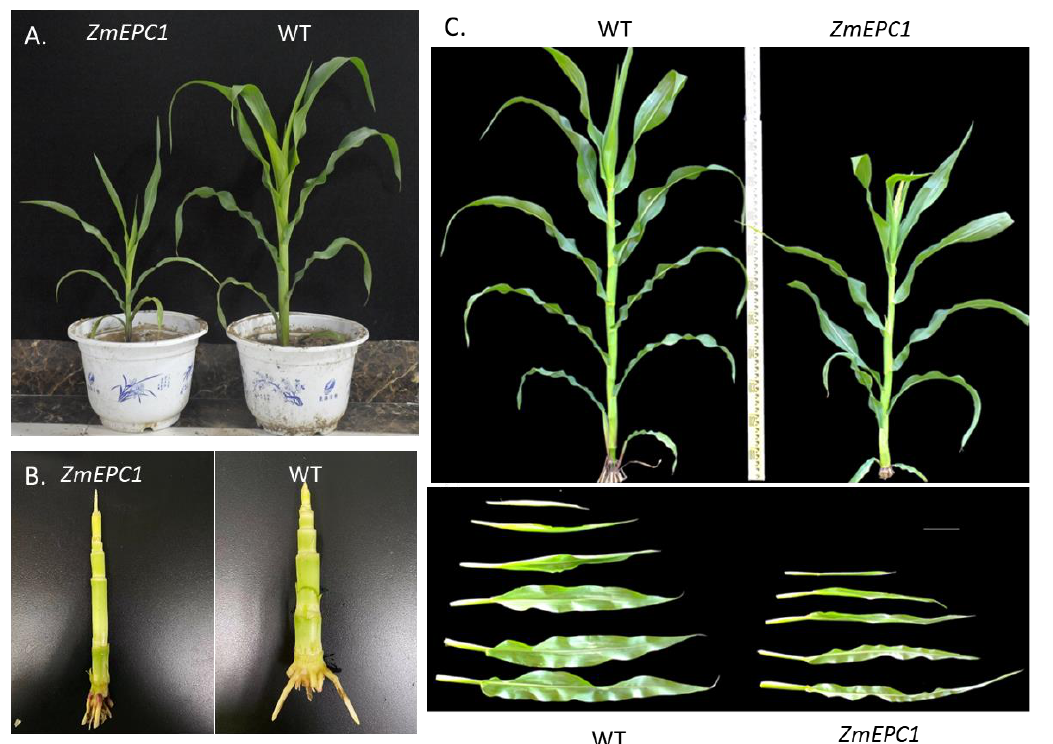
Figure 1. Phenotypic analysis of ZmEPC1 mutant and the wild type. ( A , B ) Comparative analysis of the performance of ZmEPC1 mutants and the wild type at vegetative phase; ( C ) Comparative analysis of the performance of ZmEPC1 mutants and the wild type plants at tasseling stage.